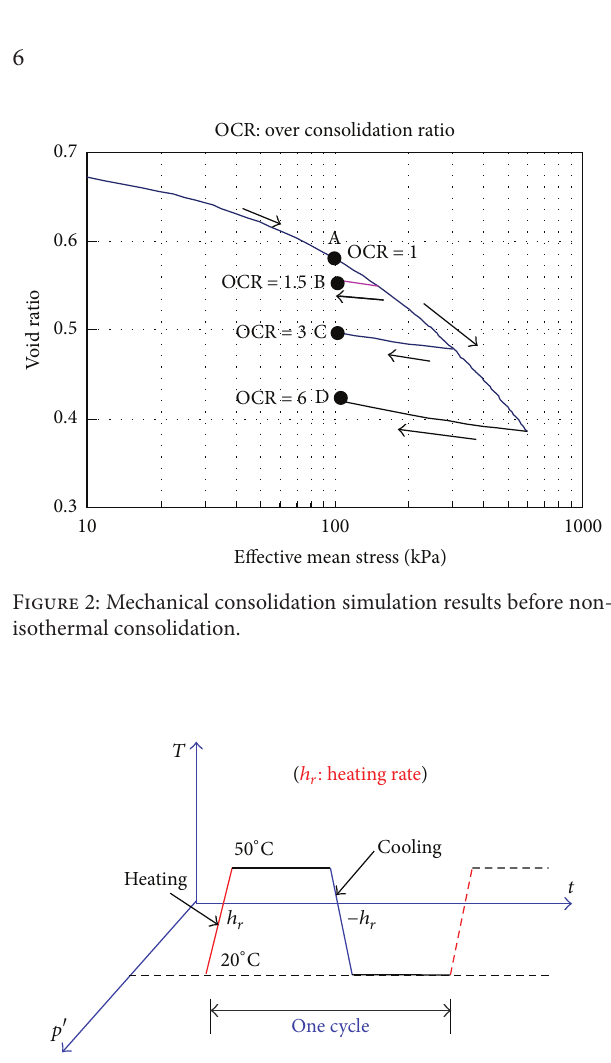
Figure 3: Repeated nonisothermal consolidation paths.